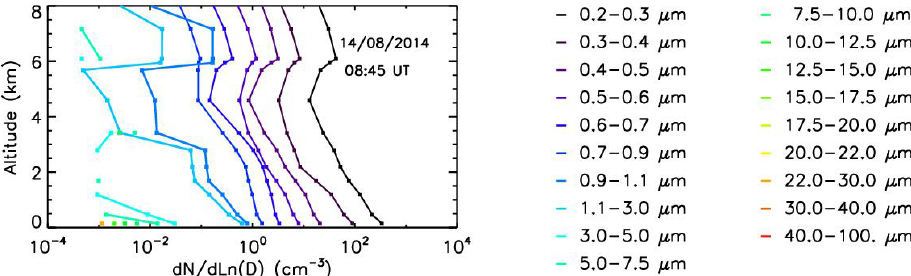
measurements were at 12:49 UTC. WALI extinctions are also available for the 29 June at around 22:30